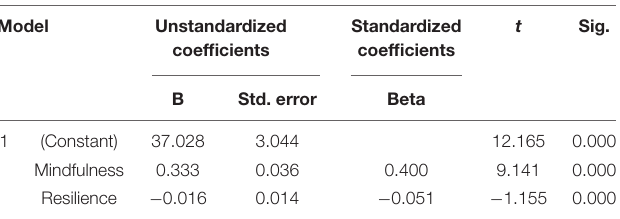
TABLE 3 | Coefficients. Model